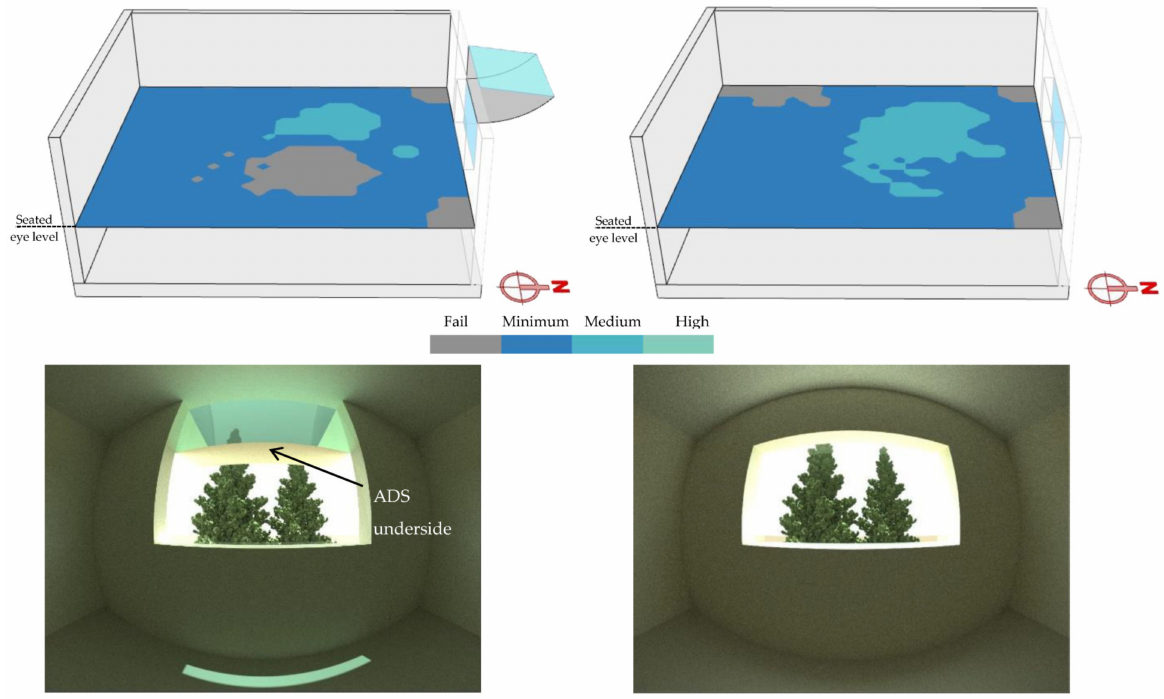
Figure 19. Mean EN17037-View Level ( top ) and comparison of view to the outside with and without the ADS